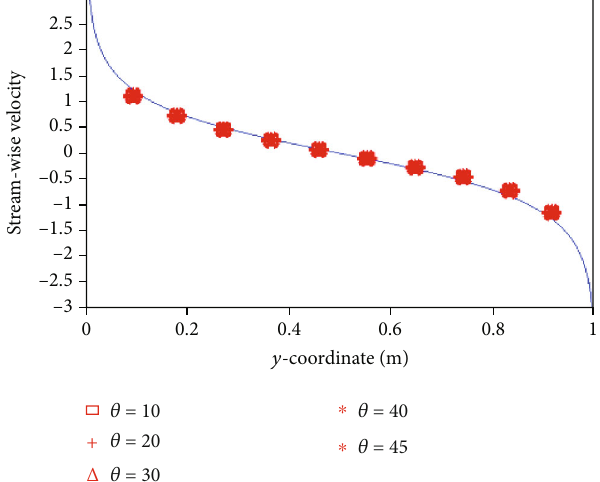
Figure 3: Comparison by equation (10).